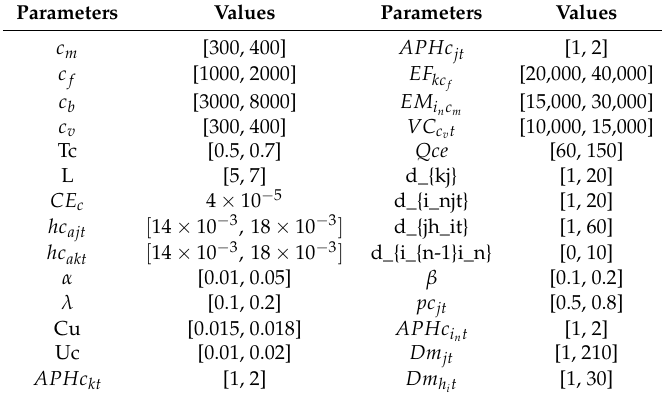
Table 8. Values of the parameters in the test problem (for references, see Khanghahi et al. [17], Heidari et al. [64], Hamdan and Diabat [18], Arvan et al. [7], and Samani et al. [16]).